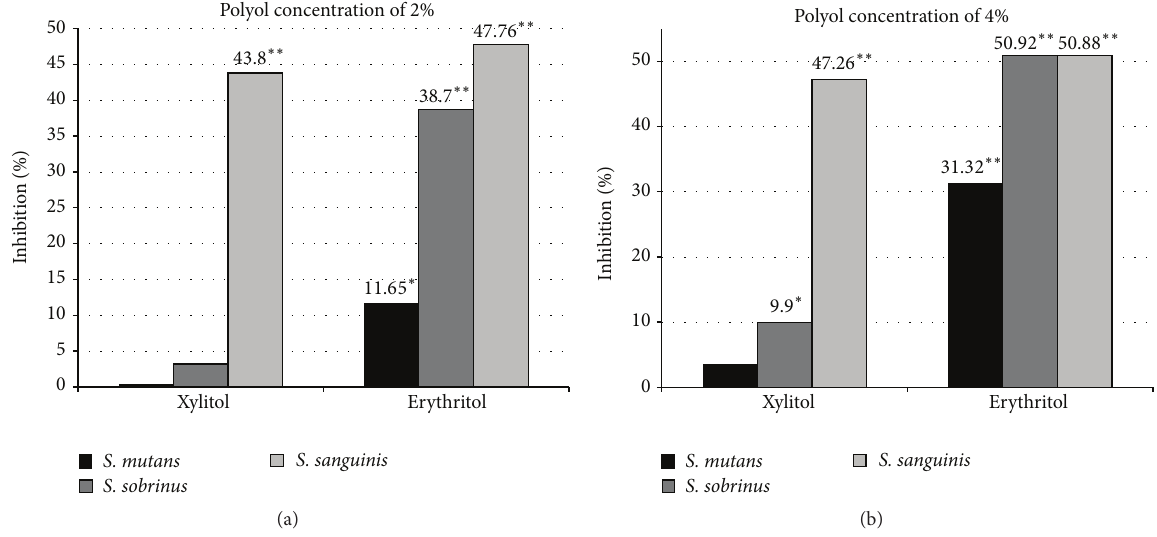
Figure 5: Mean percent inhibition of streptococci biofilm formation by xylitol and erythritol in a microtiter plate assay. From Ghezelbash et al. [14], ∗ 𝑝 < 0.05 when compared to control using analysis of variance (ANOVA) repeated measures and ∗∗ 𝑝 < 0.01 when compared to control using analysis of variance (ANOVA) repeated measures (a). From Ghezelbash et al. [14], ∗ 𝑝 < 0.05 when compared to control using analysis of variance (ANOVA) repeated measures and ∗∗ 𝑝 < 0.01 when compared to control using analysis of variance (ANOVA) repeated measures